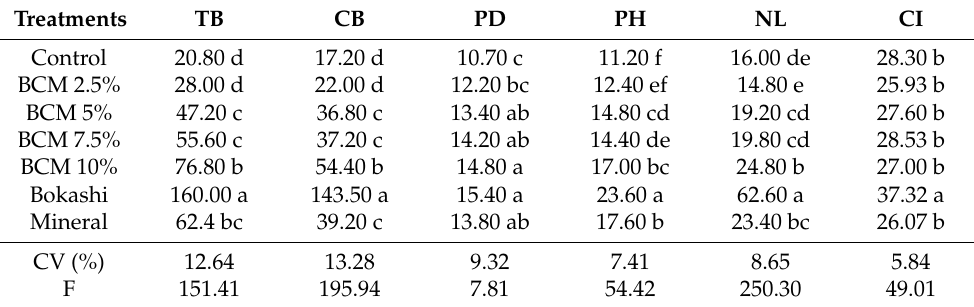
Table 1. Means of total biomass (TB) (g), commercial biomass (CB) (g), plant diameter (PD) (cm), plant height (PH) (cm), number of leaves (NL), and chlorophyll index (CI) (Falker index) in romaine lettuce Luiza cv. submitted to different concentrations of boiled chicken manure (BCM), bokashi, and mineral fertilization in a greenhouse. Londrina, Paran á State, Brazil,